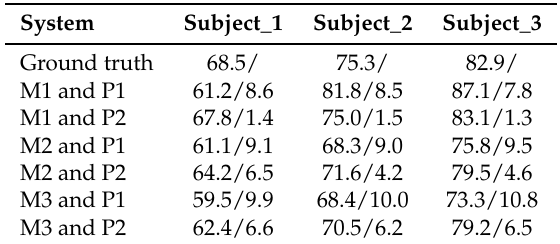
Table 4. Mean and errors of heart rates in BPM estimated by different methods when subjects were at rest. “M1 and P2” represents the results of the proposed system. The values to the right of the/represent errors.